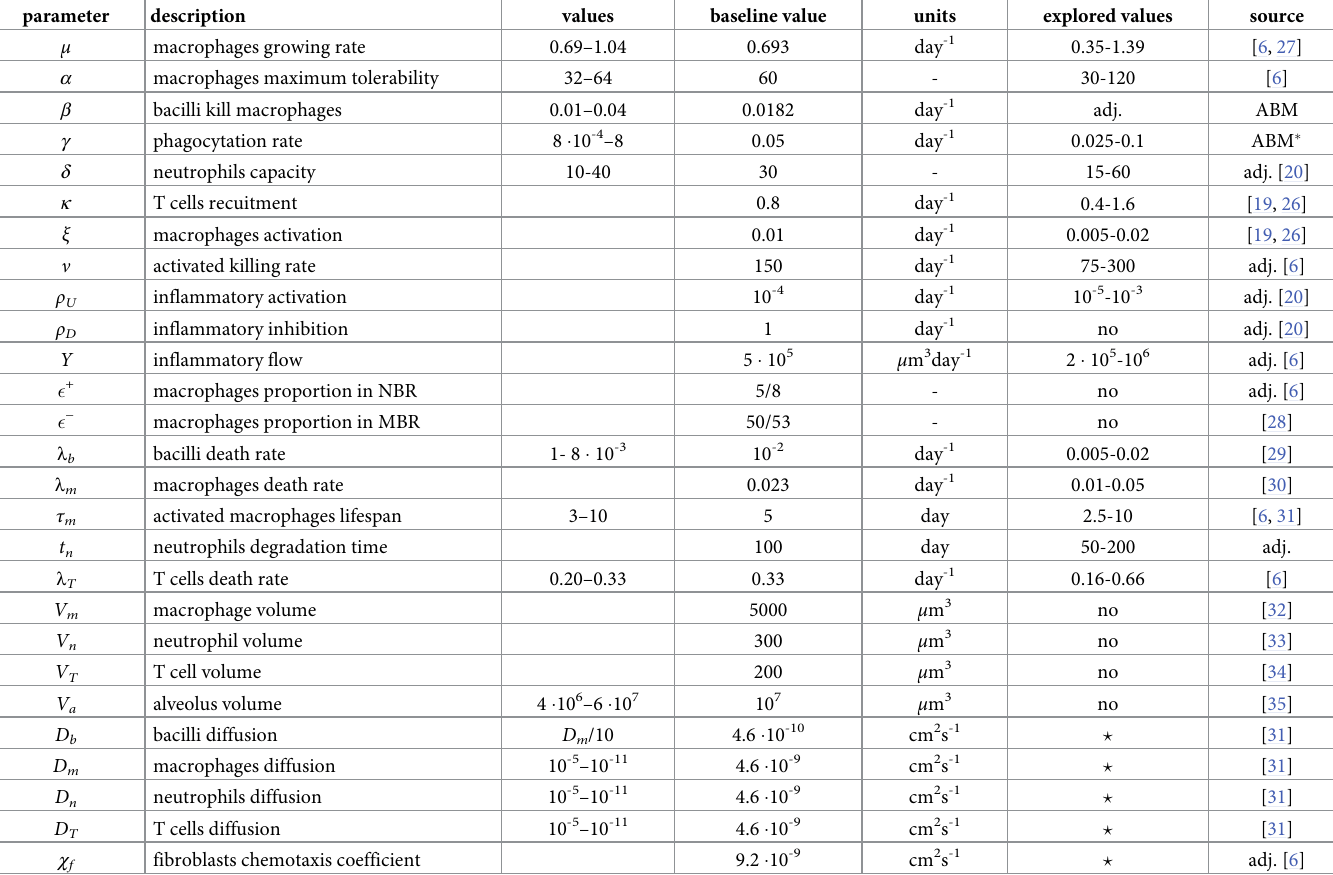
Table 1. Parameters description and values. Parameter with source ABM is adjusted from Agent-Based Model, details are on the text. Parameter with source ABM � is fit- ted from ABM and corrections are implemented. Parameters with adj. source were adjusted to reproduce tuberculosis infection dynamics according to that source. Param- eters D , D , D , D and χ are marked with ? because they are not directly explored. These parameters are explored using D and DF parameters, related with Eq 24. b m n T f Parameter D is explored between half and double its baseline value (4.6 � 10 -9 ) and DF is explored between 0.5 and